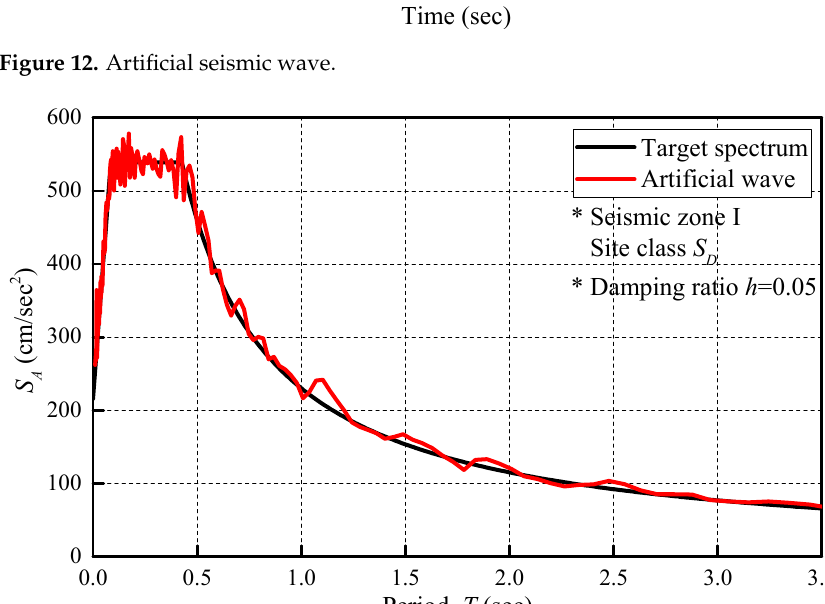
Figure 13. Elastic acceleration spectra of artificial ground motions.